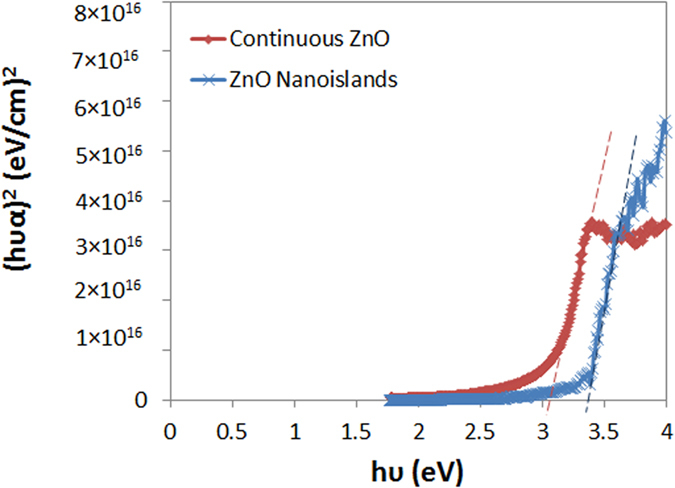
Kubelka-Munk plot of the ZnO nanoislands and continuous layer69.